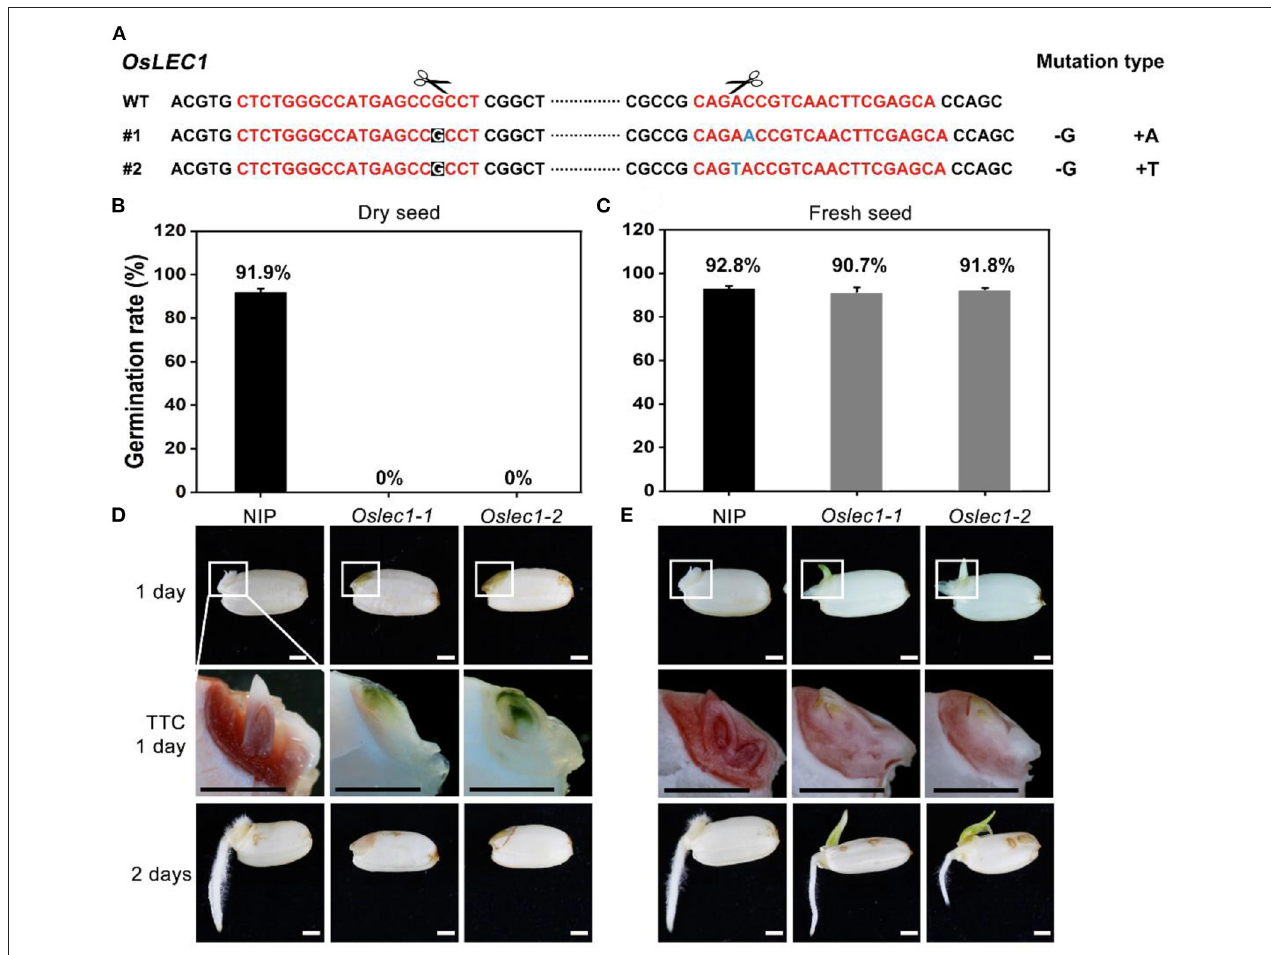
FIGURE 1 | Germination phenotypes of Oslec1 mutants. (A) Mutation sites in the Oslec1 mutant DNA. The red sequence represents the designed guide RNA (gRNA) for the wild type rice and the scissors represent the predicted knockout sites. The letters with a black background represent the deleted bases, and the blue letter represents the inserted base. (B,C) Germination rates of dry seeds and the fresh seeds of the wild type and Oslec1 mutants after 1 day of imbibition at 37 ◦ C. (D,E) Photos of the wild type and Oslec1 mutant seeds after 1 day of imbibition at 37 ◦ C (1 day) and 1 day on wet filter paper at 28 ◦ C (2 days). Photos of group “TTC 1 day” were the amplification of the regions in white boxes in group “1 day,” indicating the embryos stained by TTC for 3h at 37 ◦ C. Scale bars = 1mm.